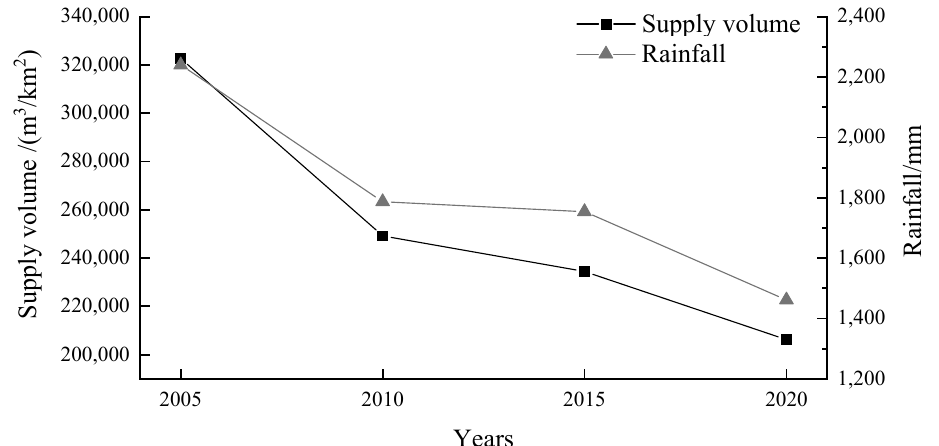
Figure 4. Variation of water supply and rainfall.